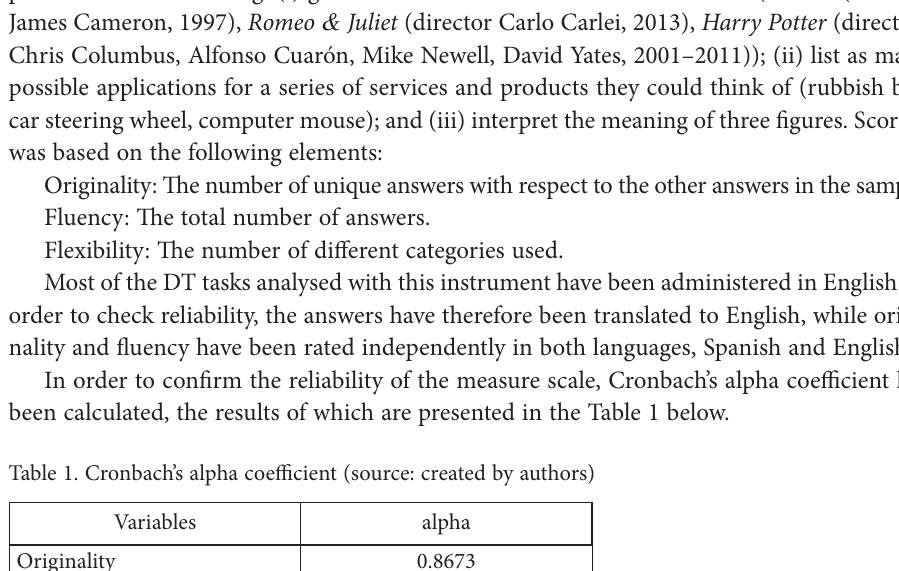
Table 1. Cronbach’s alpha coefficient (source: created by authors) Variables alpha Originality 0.8673 Fluency 0.8762 Flexibility Not available RIBS-sf 0.7469